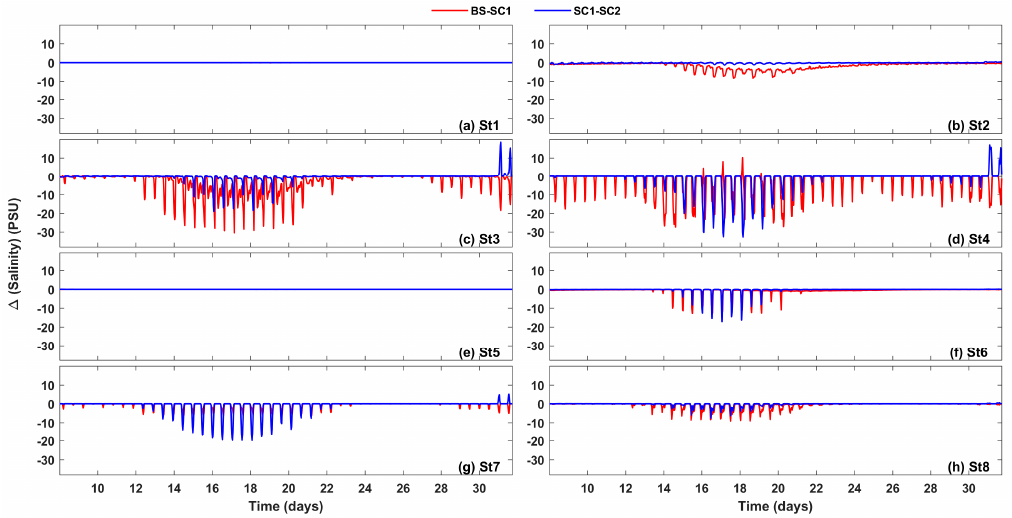
Figure 4. Time series of the salinity di ff erence, ∆ (Salinity), between the scenarios (BS–SC1, SC1–SC2), for September 2000, and the lagoon stations: ( a ) St1, ( b ) St2, ( c ) St3, ( d ) St4, ( e ) St5, ( f ) St6, ( g ) St7 and ( h ) St8.